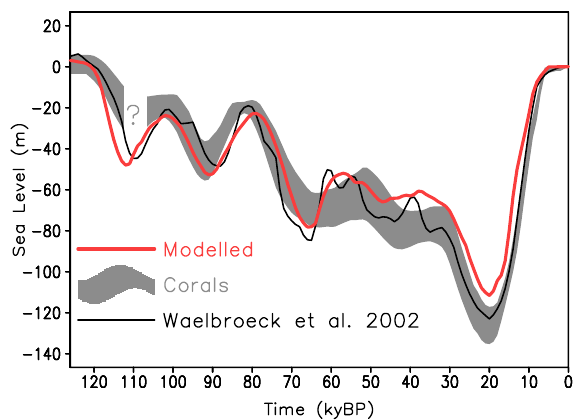
Fig. 3. Simulated and reconstructed sea-level evolution during the last glacial cycle, relative to present-day values. The red line shows the sum of the simulated Northern Hemisphere (NH) ice volume and the contribution of the Antarctic Ice Sheet (following Huy- brechts, 2002), expressed in units of sea level change. The grey area represents an interpretation of recent coral data compilations (Lam- beck et al., 2002; Thompson and Goldstein, 2006; supplementary data therein). The width of the interval corresponds to two standard deviations. A very small number of well-dated corals for MIS 5d preclude a reliable estimate of the sea level from corals for this pe- riod. The solid black line shows the reconstruction by Waelbroeck et al. (2002) based on deep ocean δ 18 O c and temperature